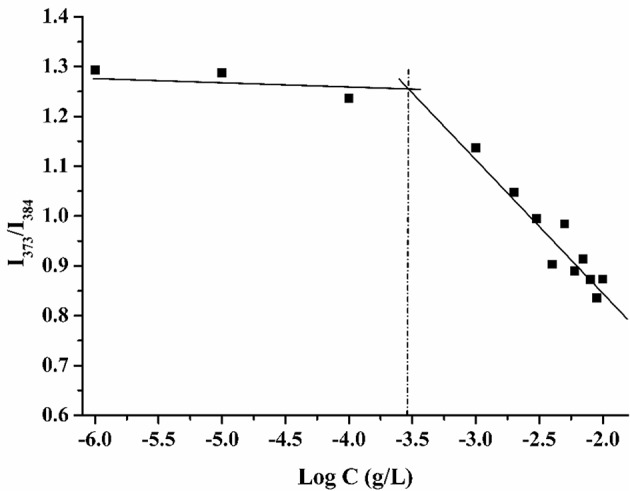
Plots of intensity ratio (I373/I384) from fluorescence emission spectra of pyrene vs. log C of calixarene derivative 8.